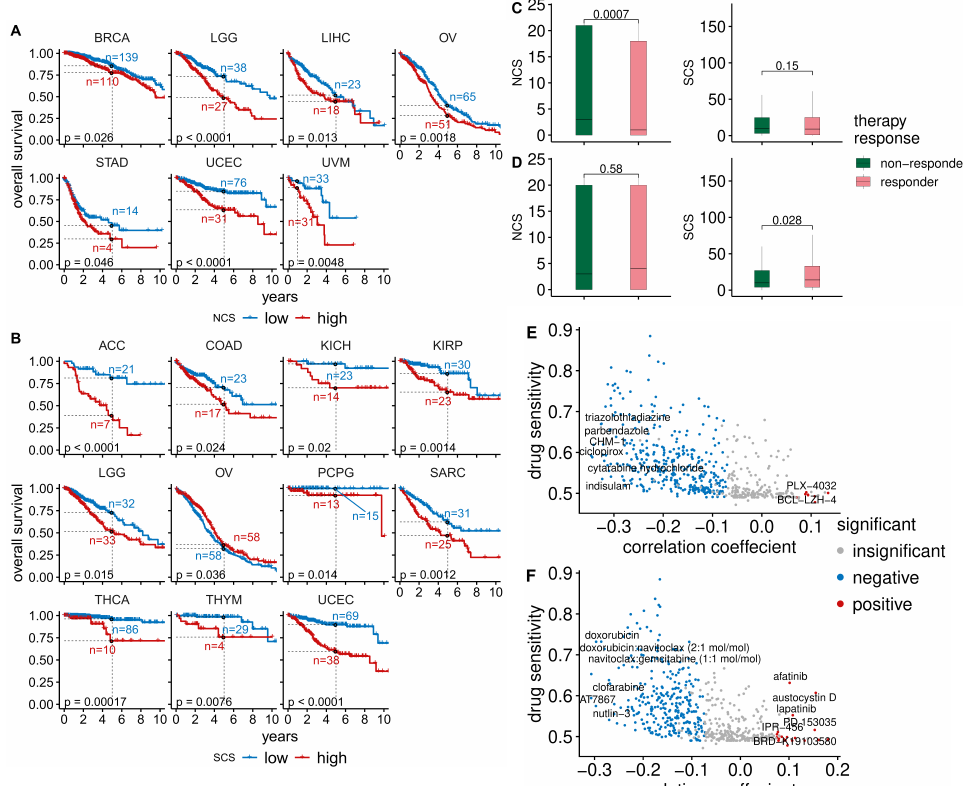
Figure 2. Clinical significance of CIN in different cancer types. ( A ) For seven cancer types there are significant differences in overall survival between patient samples with low NCS (blue) and high NCS (red). Dashed lines indicate the five-year overall survival probability of the two groups. ( B ) The SCS is associated with overall survival in 11 cancer types (low-SCS group in blue and high-SCS group in red). ( C ) Comparison of the NCS and SCS between radiotherapy responders and non-responders using a Wilcoxon rank sum test. ( D ) Comparison of the NCS and SCS between chemotherapy responders and non-responders using a Wilcoxon rank sum test. ( E ) The median drug sensitivity of a compound plotted against the correlation coefficient between drug sensitivity and NCS. Drugs with significant positive and negative correlations between their sensitivity and NCS are highlighted in red and blue, respectively. ( F ) The median drug sensitivity of a compound plotted against the correlation coefficient between drug sensitivity and SCS. Compounds whose sensitivity is significantly negatively or positively correlated with SCS are highlighted in blue and red,